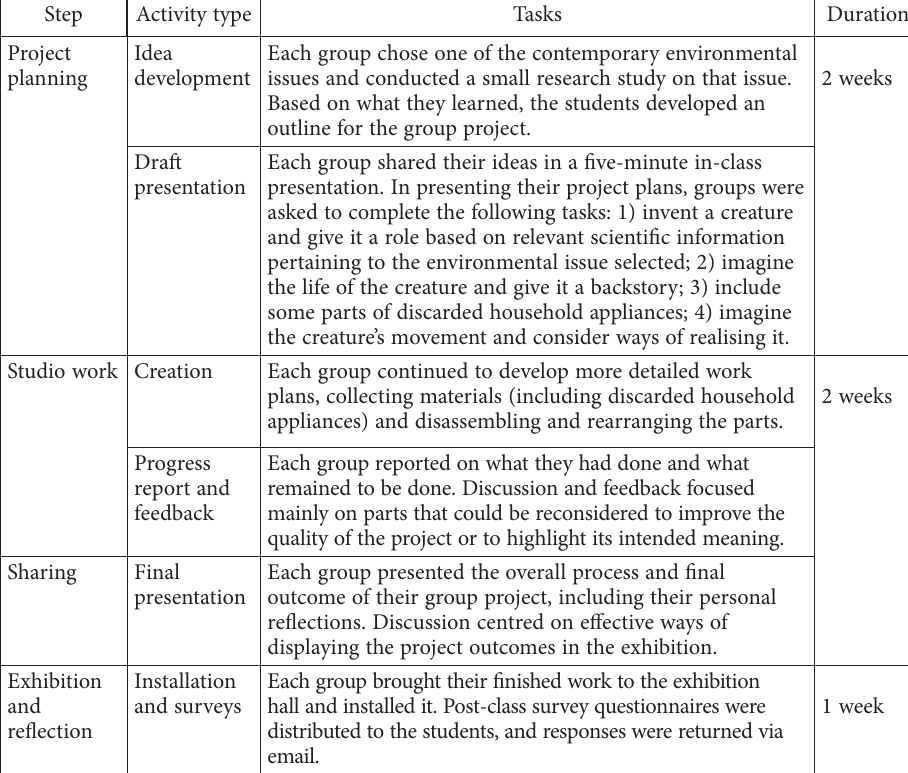
Table 2. Structure of the studioproject (source: created by